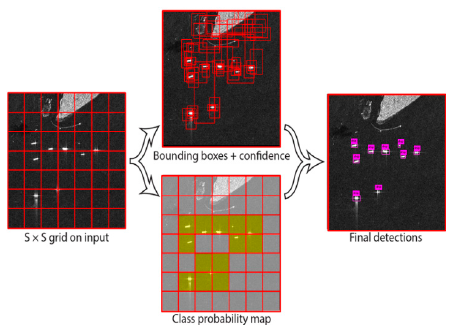
Figure 1. You Only Look Once (YOLO) system model detection as a regression problem. First partition the image into an S * S grid and for each grid cell the model predicts B bounding boxes, confidence for those boxes, and C class probabilities [6].